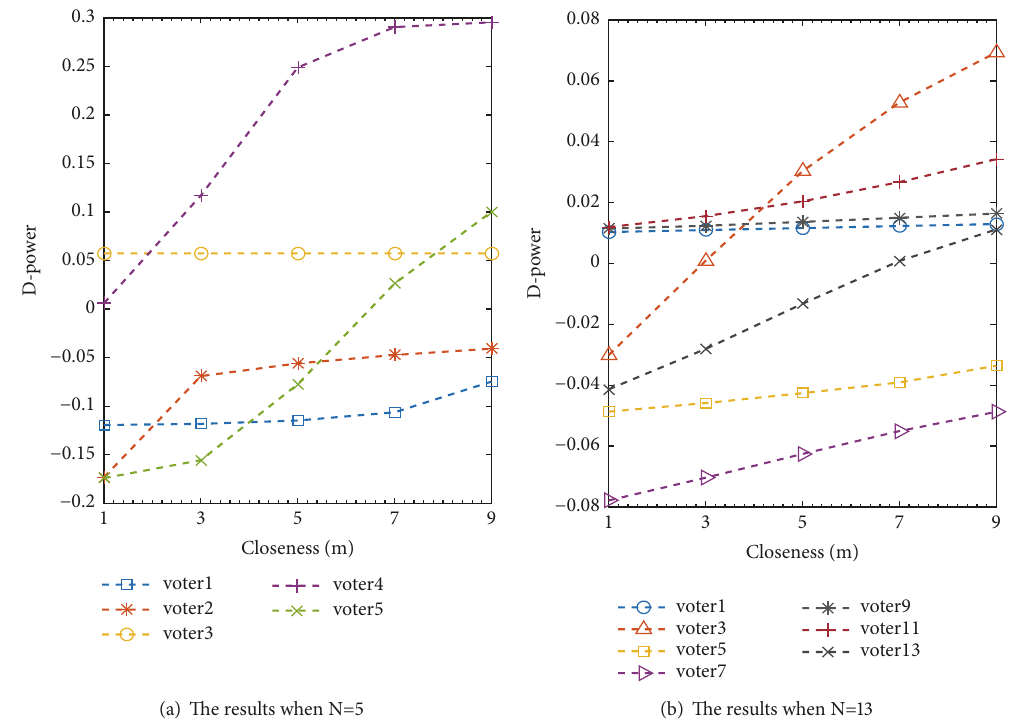
Figure 11: Robustness of voter’s closeness influence. Subgraphs (a) and (b) show the simulation results of five players (i.e., 𝑁 = 5 ) and 13 players (i.e., 𝑁 = 13 ), respectively. Voters play a repeated voting game in a social network with a 30% random connection probability, accompanied by voter 𝑖 ’s closeness with his neighbors 𝑚 𝑖𝑗 = 𝑚 𝑖𝑘 (∀𝑗,𝑘 ∈ Γ 𝑖 ) increasing from 𝑚 𝑖𝑗 = 1 to 𝑚 𝑖𝑗 = 9 while keeping the other parameters.